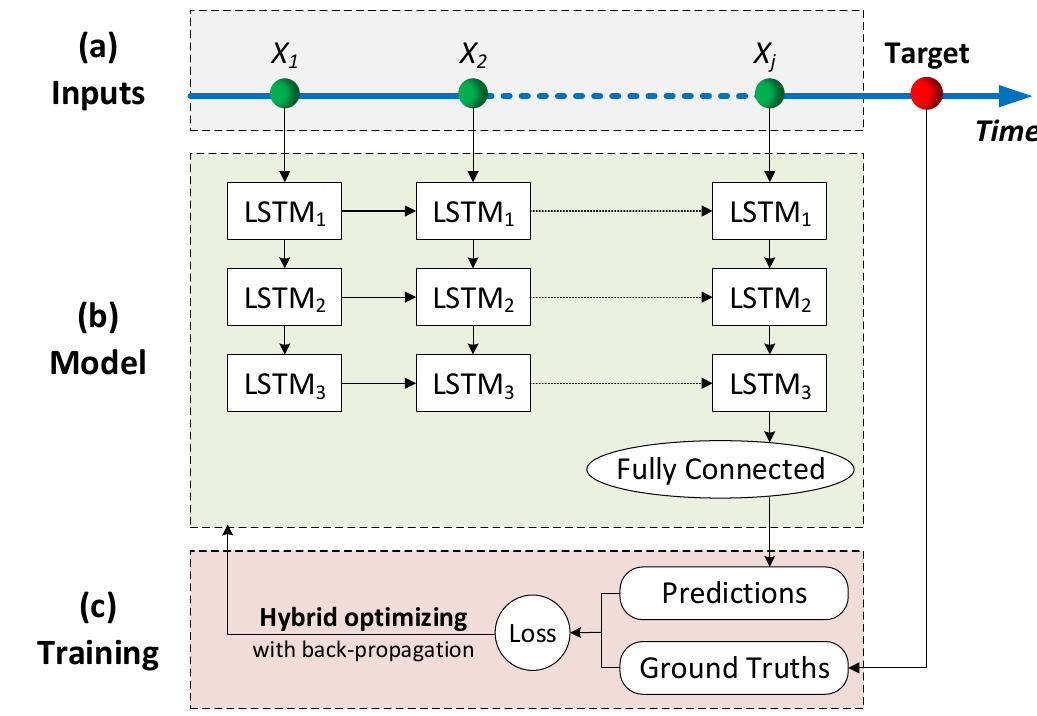
Figure 4. Framework of the hybrid optimized LSTM network.